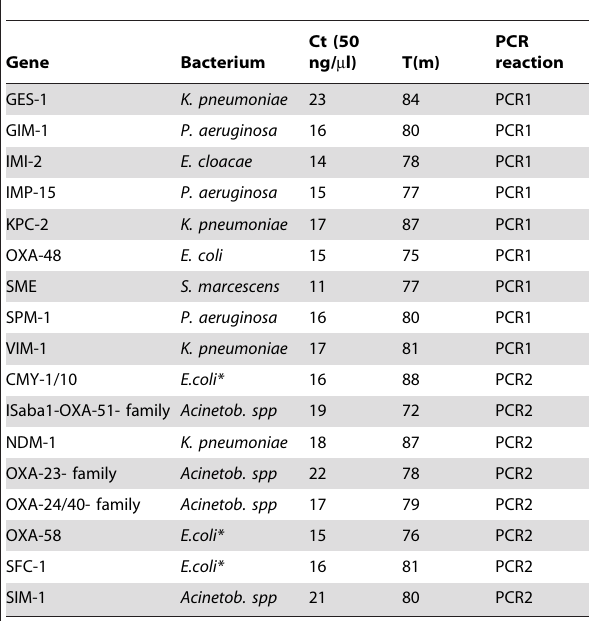
Table 3. Control